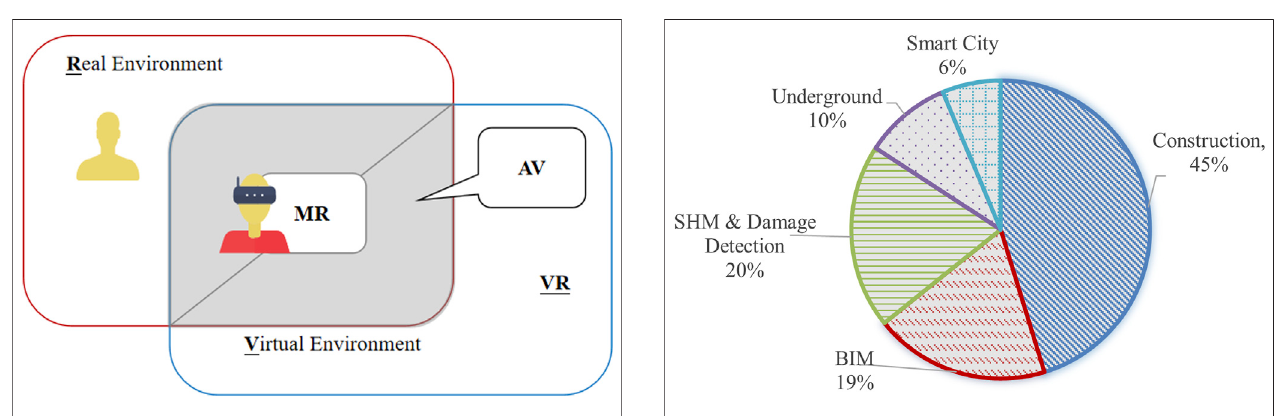
FIGURE 4 | Percentage of AR applications in civil infrastructure (2016 –